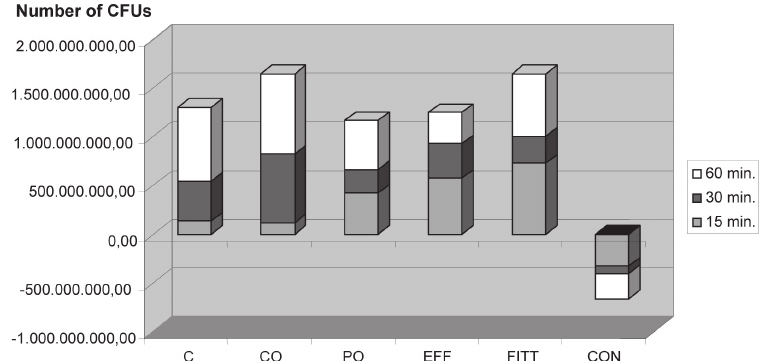
Figure 2- Number of Colony-Forming Units (CFU) at baseline minus number of CFUs 15, 30 and 60